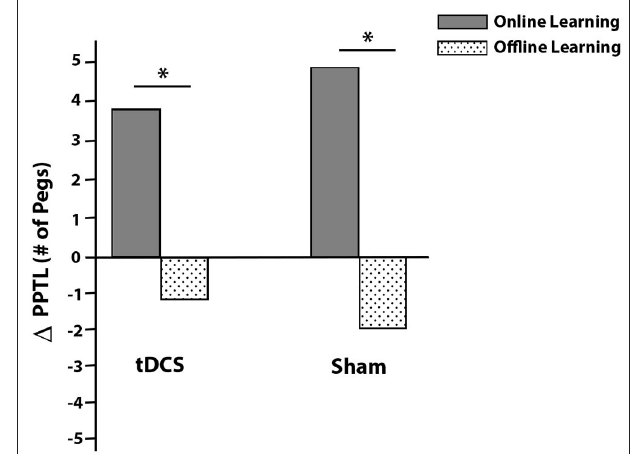
FIGURE 4 | Average PPT L online (solid gray) and offline (dotted) learning effects by intervention group. Online effects are within session improvements while offline effects are improvements that occur between sessions (consolidation). Daily online and offline effects were summed to obtain total online and offline changes in scores (y-axis 1 PPTL). * p <